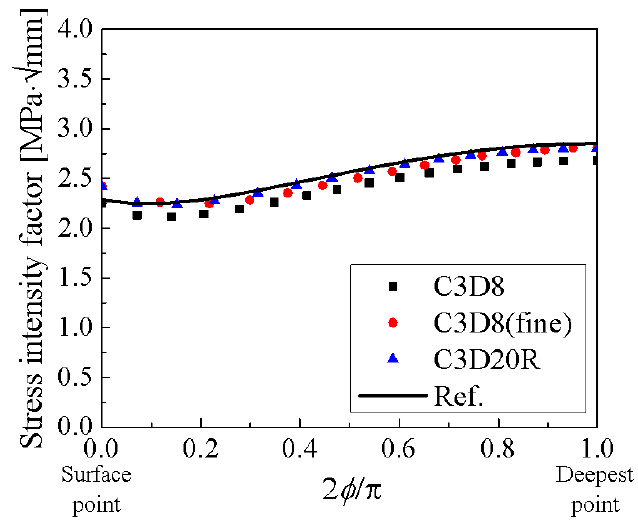
Figure 5. Comparison of SIF according to element types [22].